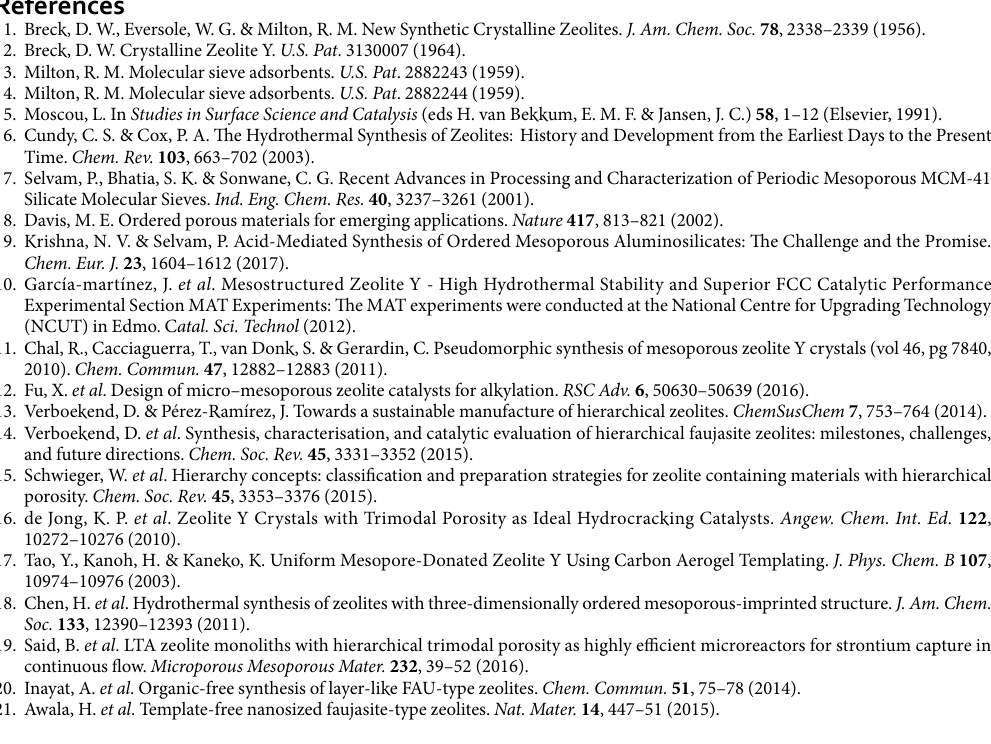
selectivity (Fig. 14) of 85% and 80% towards 4- t -BP owing to the facile diffusion of products in the uniform mes- opore channels. Furthermore, unlike the conventional zeolites, the hierarchical catalysts have shown excellent life times (Fig. 15) without much change in the efficiency up to 24 h of reaction stream. Further studies are in progress to test the cracking activities of the prepared zeolites in the pilot scale.